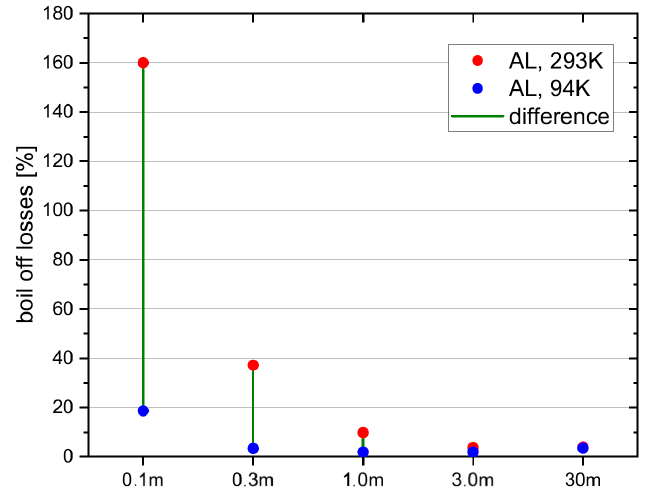
Figure 9. Relvative boil-off losses for different tank